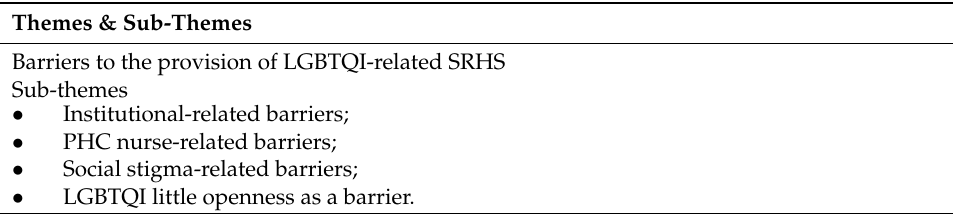
Table 1. Emerged themes and